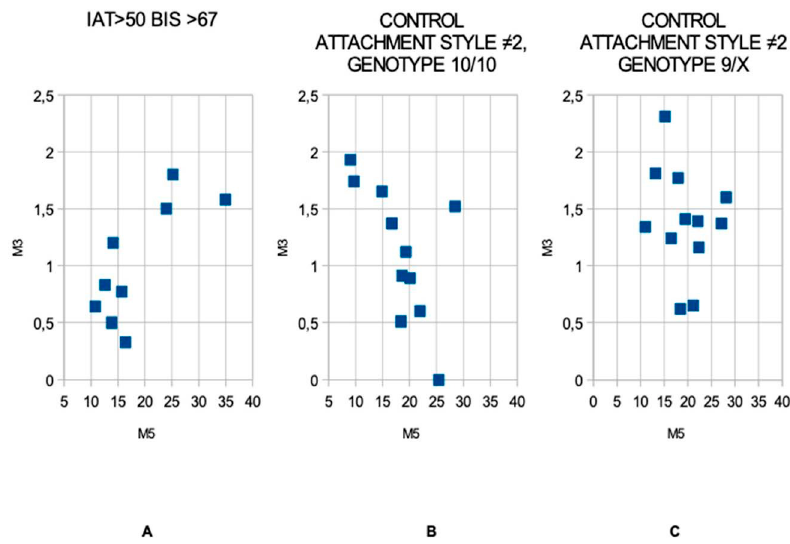
Figure 2. Cross-correlation between CpG3 and CpG5: the high IAT (IAT > 50 and BIS > 67) group (panel A ), seems to show a positive correlation, while control groups matched to attachment style 2, both with genotype 10 / 10 (panel B ) and genotype 9 / x (panel C ), show negative correlations. Note that the mean methylation levels, expressed in % of methylated cytosine over total cytosines, are similar in all subgroups. In graphic for genotype 10 \ 10 (panel B ) only 11 points were marked instead of 12 due to two subjects having the same M3 and M5 values and, therefore, occupying the same position.